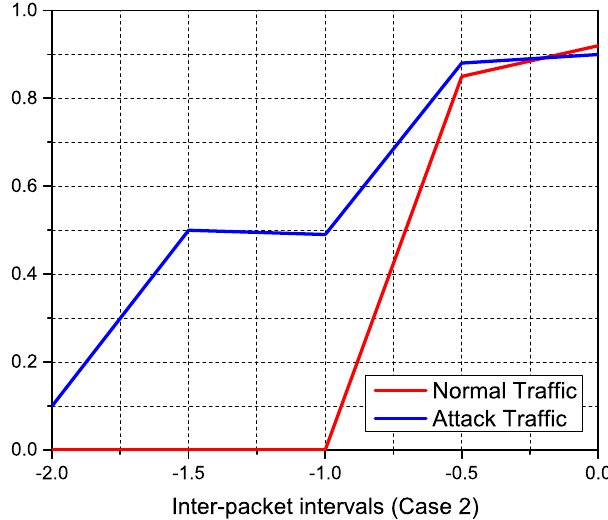
Figure 21. DDoS anomaly detection from IoT traffic feature-statistics according to the inter-packet ∆ T intervals of d . dt